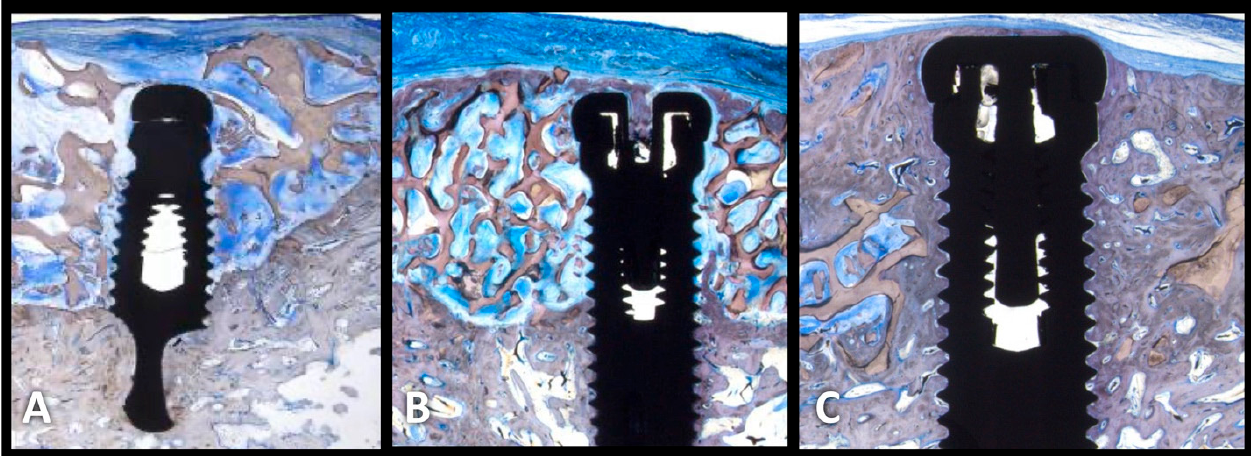
Figure 2. Vertical bone regeneration using rhPDGF + Bone block. ( A ) GBR using deproteinized bone block and collagen membrane. Bone block embedded in connective tissue and absence of new bone (4 months); ( B ) GBR using deproteinized bone block and collagen membrane and rhPDGF. New bone is present in the apical and coronal aspects of the implants, but the center is dominated by connective tissue (4 months); ( C ) GBR using deproteinized bone block with rhPDGF (no membrane). New bone is present throughout the entire length of the implants (4 months).